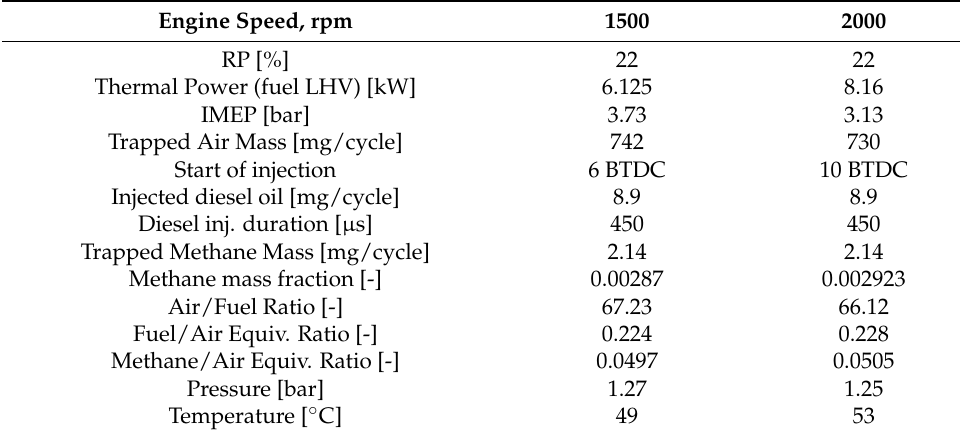
Table 6. Operating conditions in computational